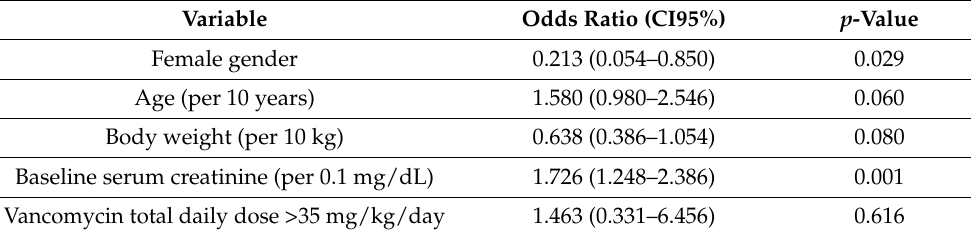
Table 3. Multivariate analysis of the risk factors for having a supratherapeutic PKPD target.